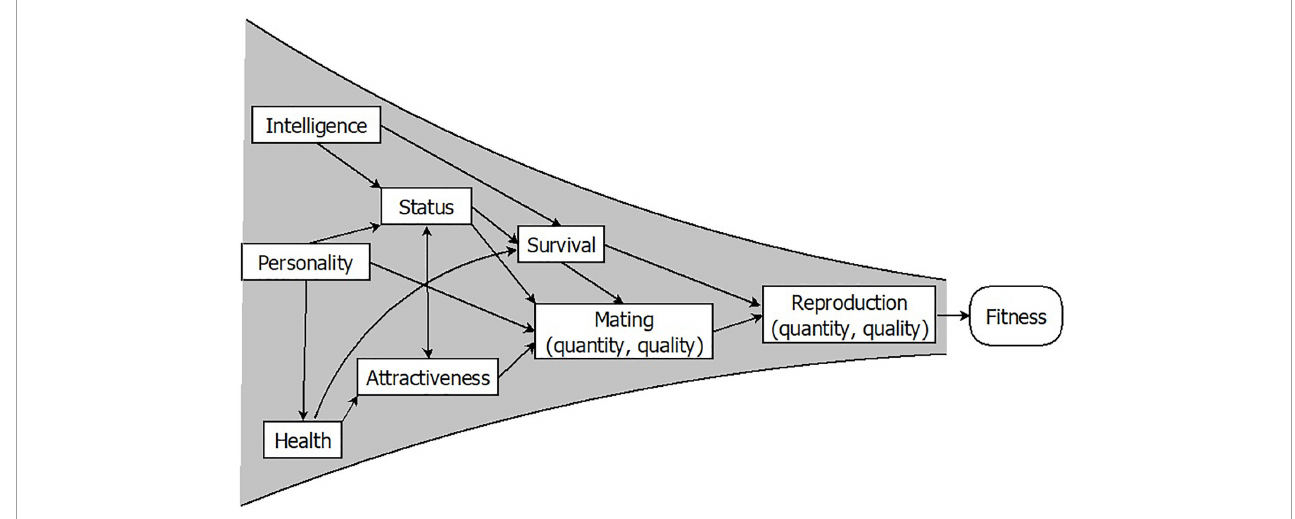
FIGURE1 Individual traits must pass through the reproductive success funnel to be evolutionarily relevant. Adapted from Gutiérrez (38) with permission from Siglantana Editorial.